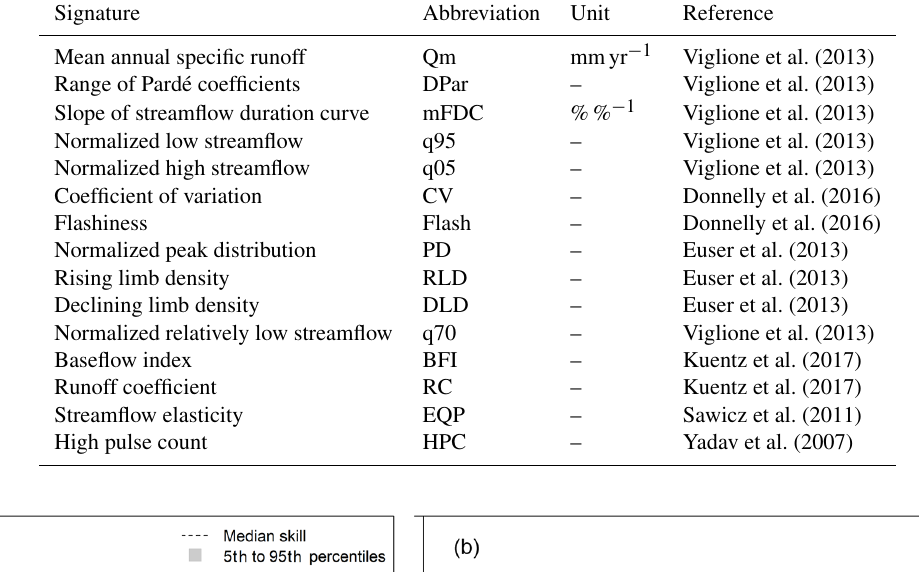
Table 1. Hydrologic signatures used for catchment functioning.